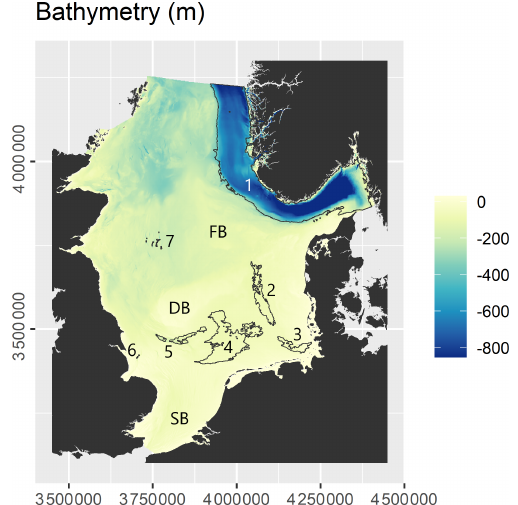
Figure 1. Overview of the study site. Letters refer to localities: DB – Dogger Bank; FB – Fisher Bank; SB – Southern Bight. Numbers refer to areas of sediment deposition: 1 – Norwegian Trough; 2 – Elbe palaeo-valley; 3 – German Bight; 4 – Oyster Ground; 5 – Outer Silver Pit; 6 – Inner Silver Pit; 7 – Devil’s Hole. Refer to Sect. 3.2 for the delineation of areas of sediment